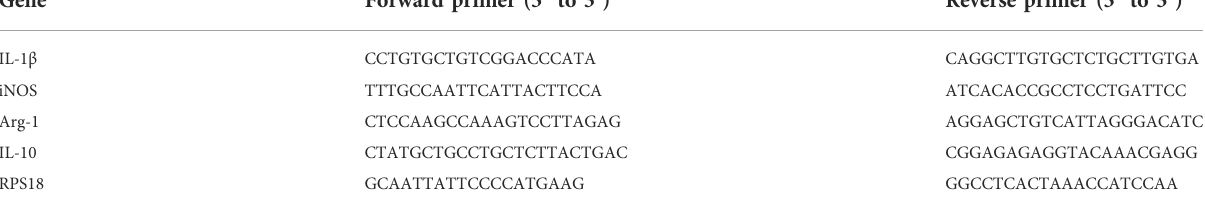
TABLE 1 Primer sequences used for quantitative real-time PCR.